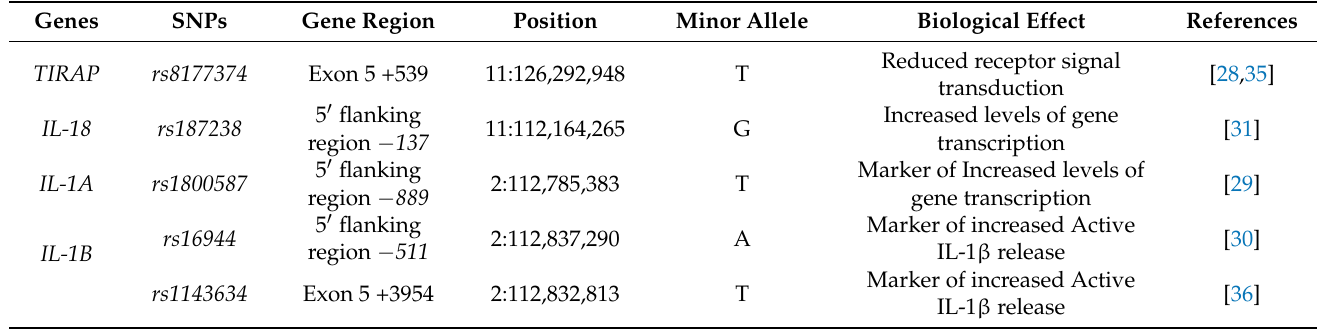
Table 2. Genes, reference number (rs), localization and position of SNPs investigated in the